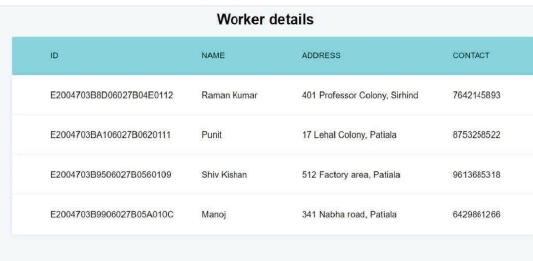
Figure 21: Worker’s details through cloud database.